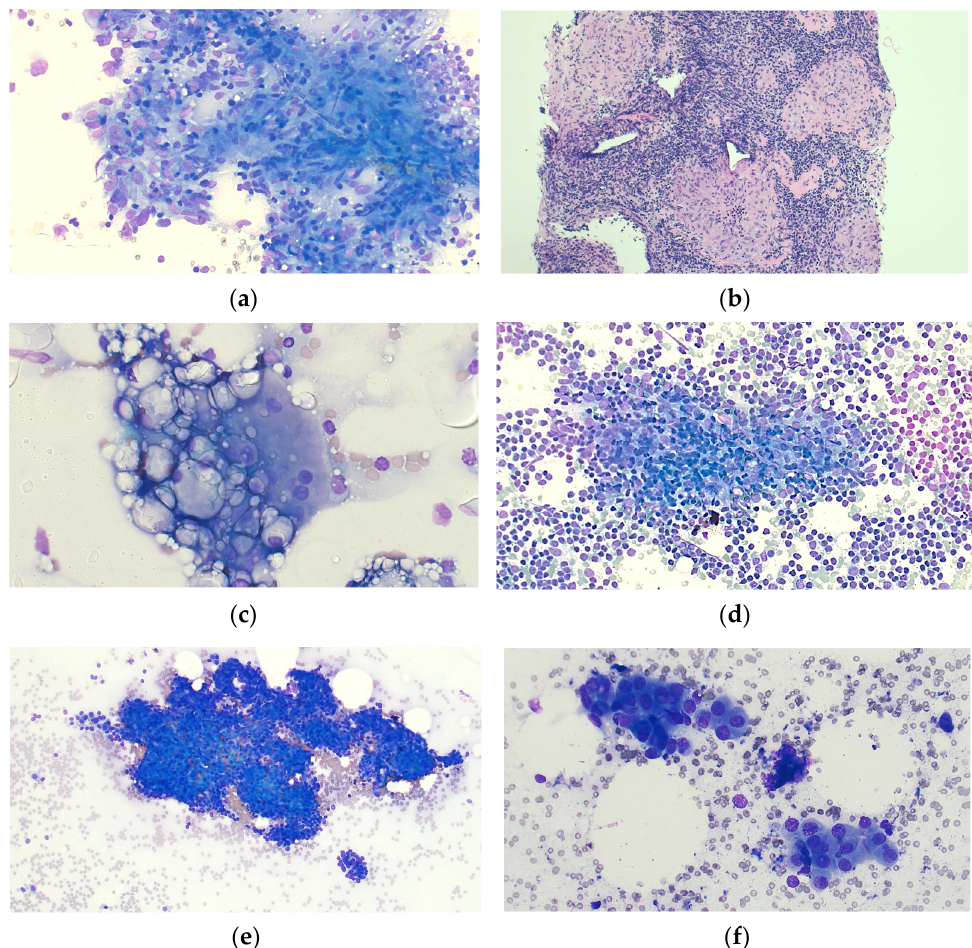
Figure 9. Examples of potential false positive diagnoses. ( a ) Smear demonstrating a cluster of epithelioid histiocytes forming a granuloma in a case of granulomatous lymphadenitis. DQ ×200. ( b ). Example of a core biopsy in a case of sarcoidosis. H&E ×100. ( c ) Multinucleated giant cells associated with refractile silicone in a woman with implants and silicone lymphadenopathy are more easily recognizable. DQ ×400. ( d ) Germinal centre tissue fragment in a reactive node. DQ ×100. ( e ) Cytologically bland epithelial cells with a bimodal pattern, including myoepithelial cells and background bare bipolar nuclei, in a case of heterotopic axillary benign breast tissue, DQ ×100, with ( f ) contrasting malignant cells from the concurrent breast aspirate. DQ ×200.